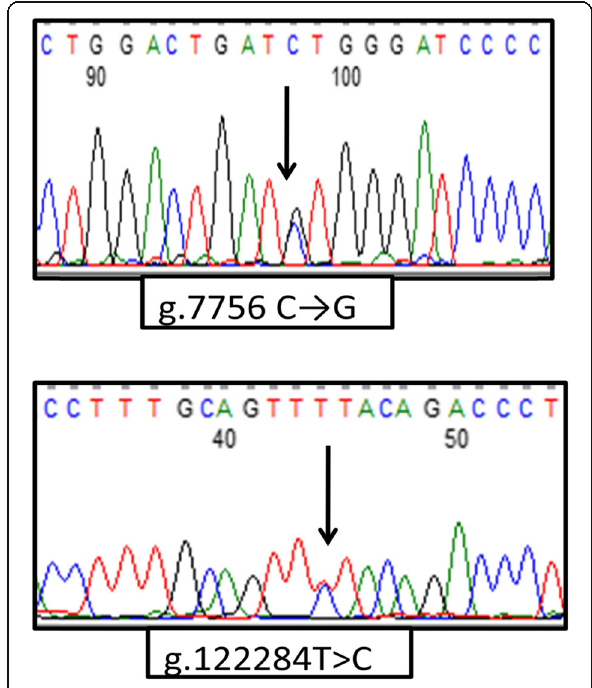
Fig. 1 Electropherograms of 2 variants observed during the screening of the FOXO3 gene in the study